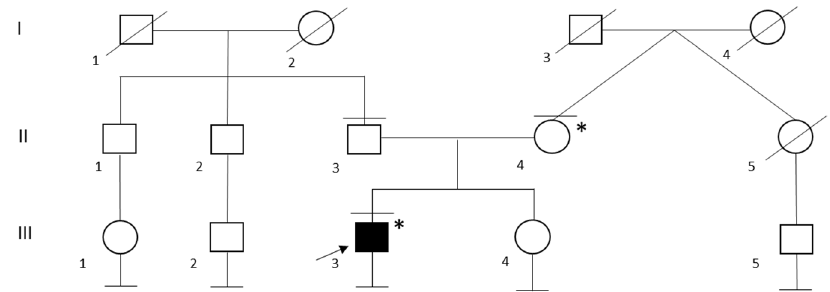
Figure 3. Family Pedigree of Patient ID 7. Black circle and squares indicate individuals with a clinical diagnosis of dilated cardiomyopathy. Black arrow indicates the proband. Black lines at the top indicate individuals who underwent to genetic testing. Black lines at the bottom indicates individuals without offspring. * G1737Dfs*16 heterozygous carrier.